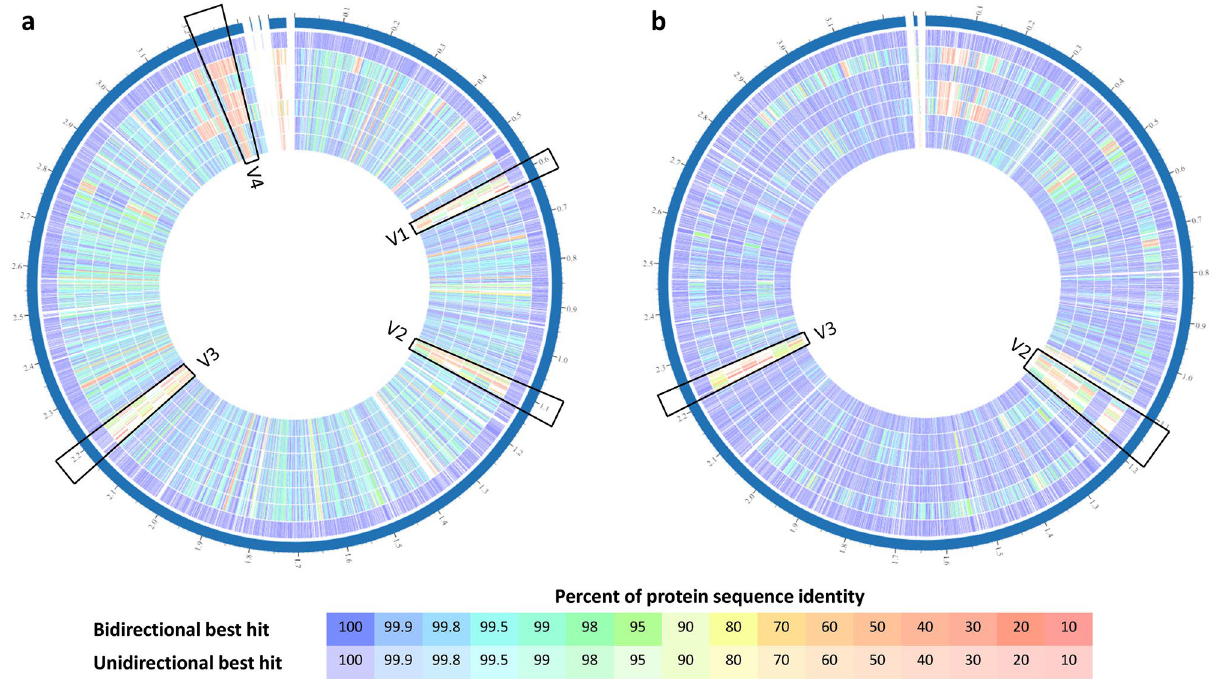
Figure 5. Comparison of the genomic features of the selected TanA+ strains with two reference L. plantarum strains. ( a ) With WCFS1 as reference strain, where four variable regions are distinguished (V1-V4); ( b ) with ATCC 14917 as reference strain, where two variable regions are perceived (V2 and V3). List of tracks, from outside to inside: 1 , reference strain; 2 , PROBI S126; 3 , PROBI S204; 4, RKG 1-473; 5 , RKG 1-500; 6 , RKG 2-219; 7 , RKG